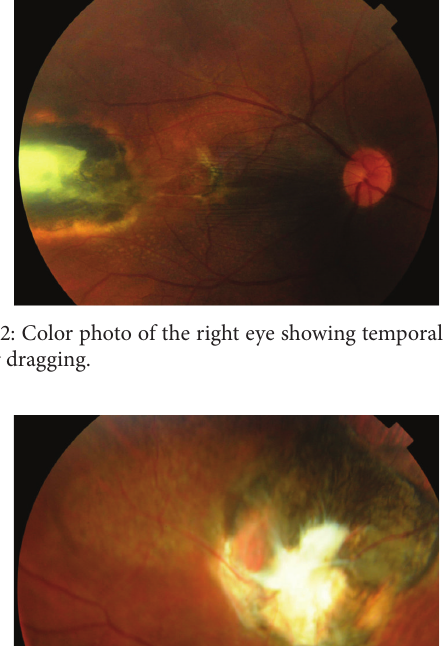
Table 3: Postoperative complications.